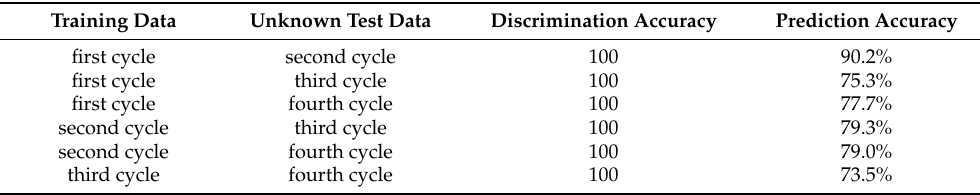
Table 3. LDA prediction results for unknown data sets obtained from different cycles of measurement after training with data sets from the first cycle, second cycle, and third cycle.